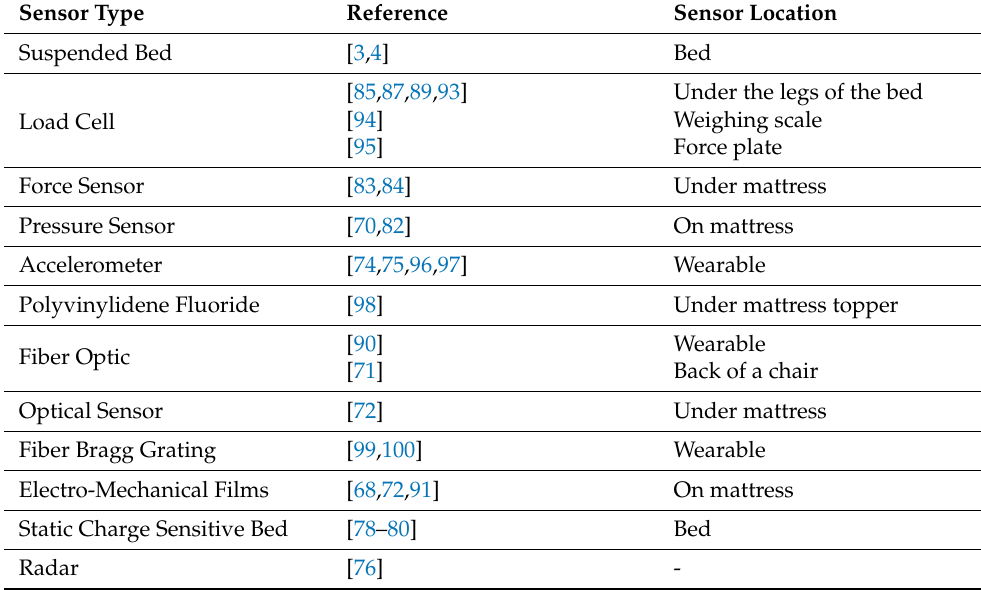
Table 2. Summary of BCG sensors’ diversity in the articles